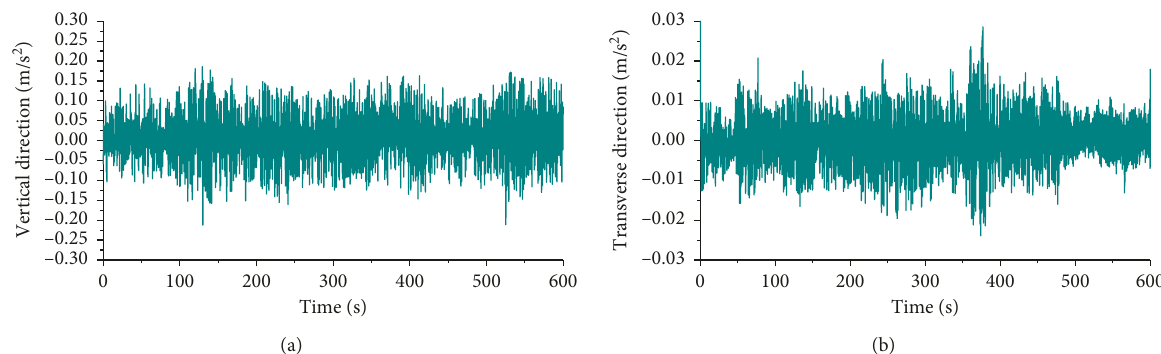
Figure 5: Acceleration in the middle of the bridge girder at 5.0m/s: (a) vertical and (b) transverse.